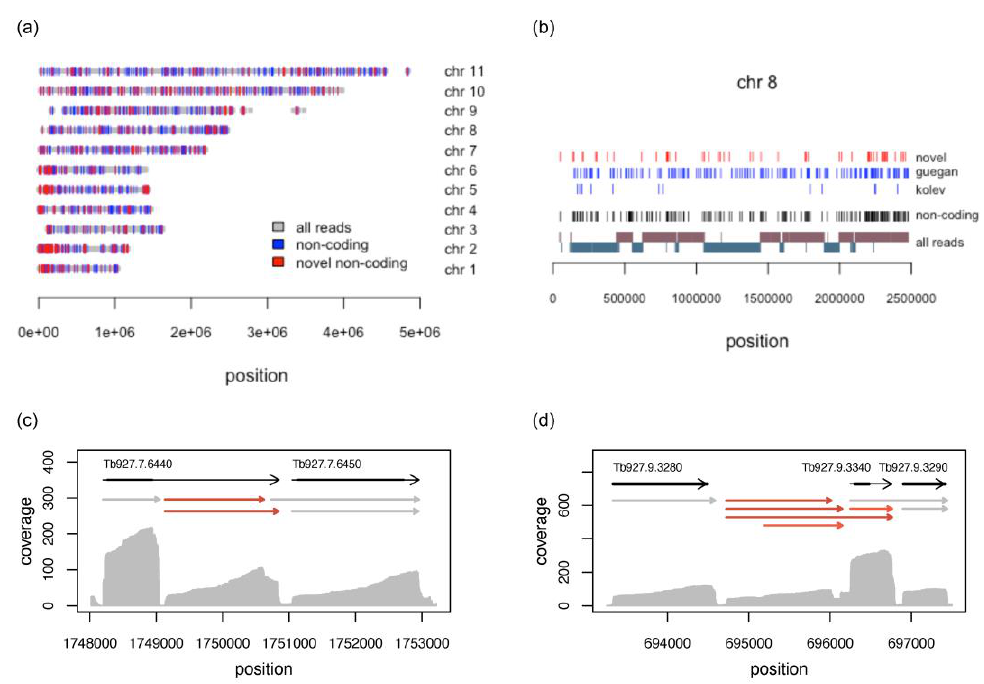
Figure 3. Genomic localization of lncRNA genes. ( a ) Localization of lncRNAs genes on the 11 Mbp chromosomes (chr) of T. brucei. Regions covered by reads, based on all bloodstream- and procyclic- stage libraries are in grey. Known lncRNA genes [15,16] are in blue. Novel lncRNA genes (this study) are in red. ( b ) Detailed view of chromosome 8. The localization of all novel lncRNA genes (red) is separated from the published sequences [15,16] in blue. For comparison, “all reads” are shown in a strand-specific manner. The top line represents the plus strand, and the bottom line the minus strand. ( c ) Clustering of two new lncRNAs (red) as “minor” splice-acceptor or polyadenylation-site variants. ( d ) Complex clustering of novel lncRNAs. Sequencing-coverage plots (grey) from the combined reads of all bloodstream-stage libraries are shown. Grey arrows represent annotated transcripts with coding regions as thick black lines. Grey arrows are predicted coding transcripts and red arrows represent new lncRNAs.